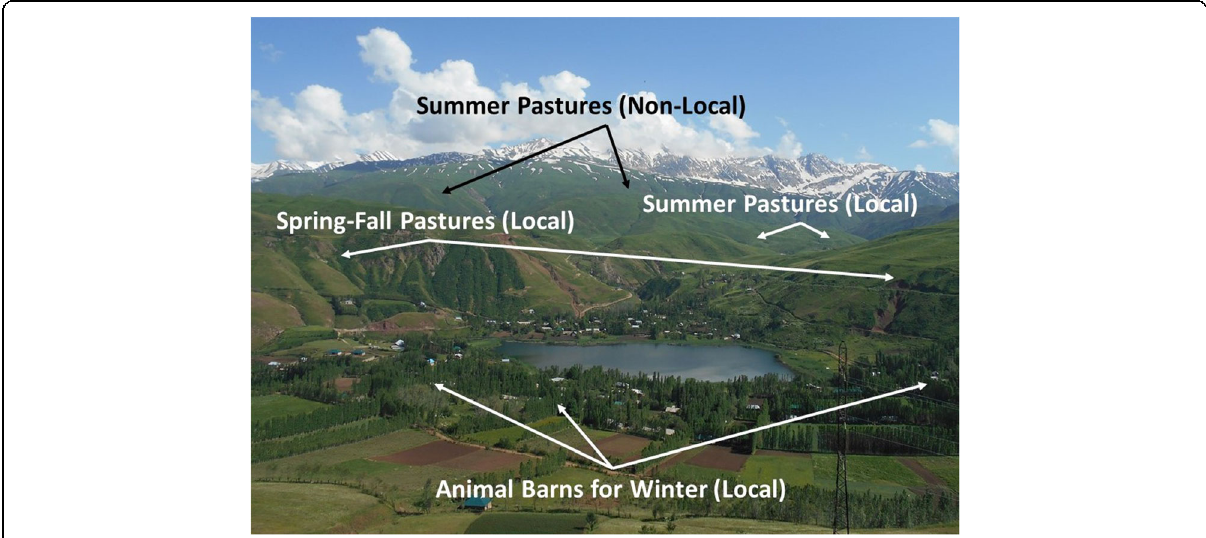
Fig. 3 Spatial organization of livestock areas in typical village of study area